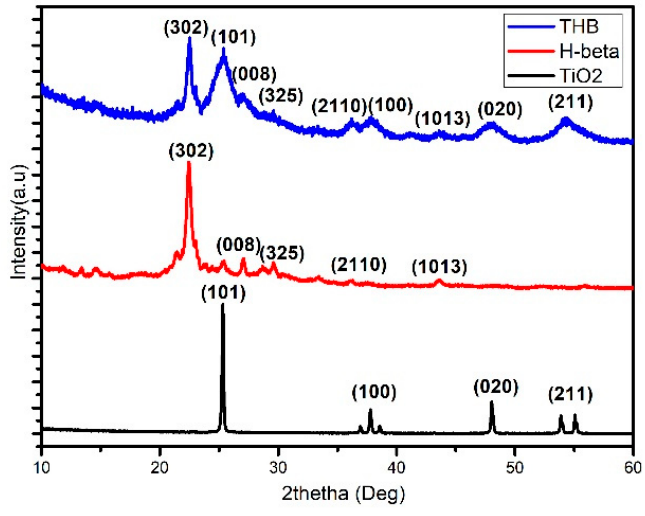
Figure 1. XRD plots of THB and comparison with commercial H-beta and standard TiO 2 (183767-ICSD) samples.